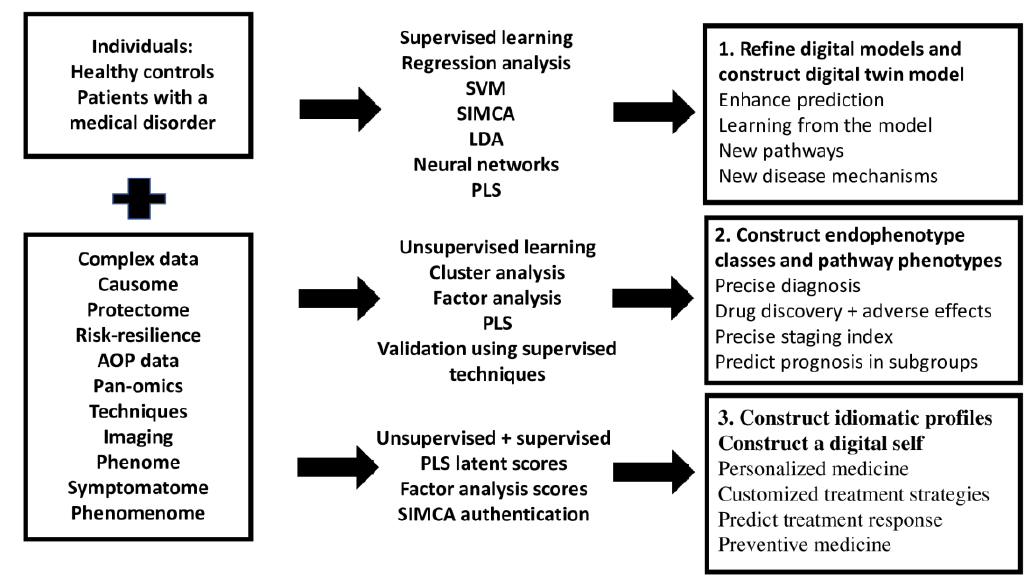
Figure 1. The three different steps which characterize precision medicine, the machine learning techniques that can be used to achieve these goals, and the products of these techniques. AOP: adverse outcome pathways; SVM: support vector machine, SIMCA: soft independent modeling of class analogy; LDA: linear discriminant analysis, PLS: partial least squares path analysis. The labeled data to conduct supervised pattern recognition methods always consist of paired input (explanatory, independent variables, e.g., features of MDD/MDE) and correct output (dependent) data, namely the predefined classes (e.g., a correct depression model of MDD/MDE versus controls) or continuous outcome scores, for example, severity of